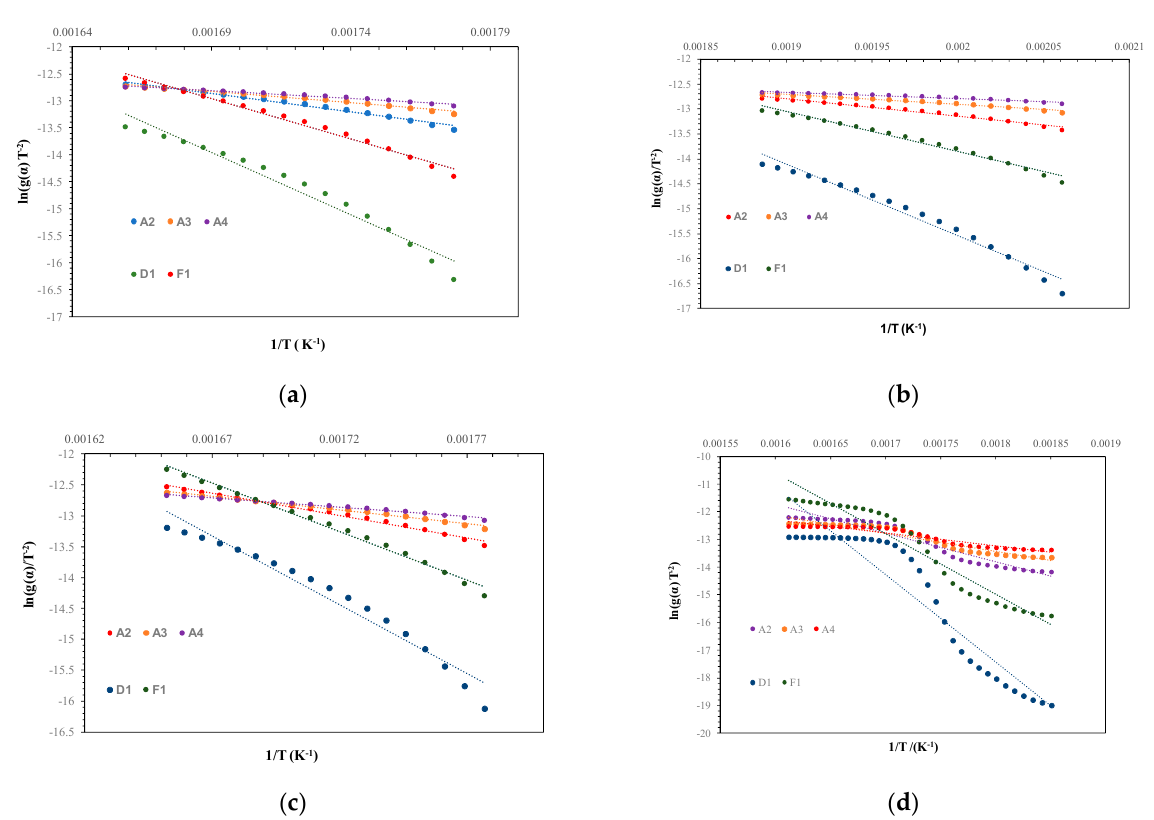
Figure 4. Plot ln( g ( α ) T − 2 ) versus 1/ T of ( a ) rice starch; ( b ) potato starch; ( c ) wheat starch; and ( d ) corn starch.